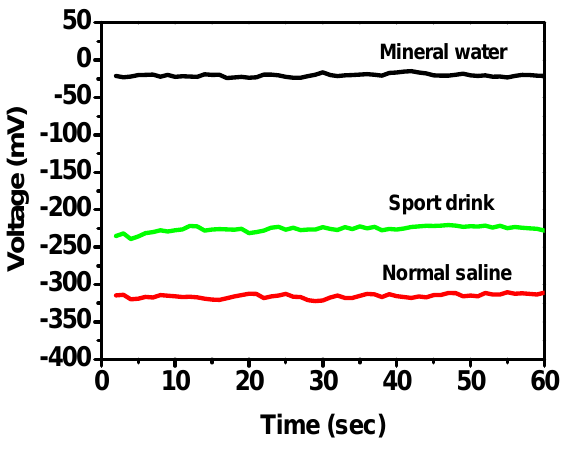
Figure 10. Sodium ions test in commercial mineral water, sport drinks, and physiological salt water with sodium-selective-membrane/anodized-ITO/ITO